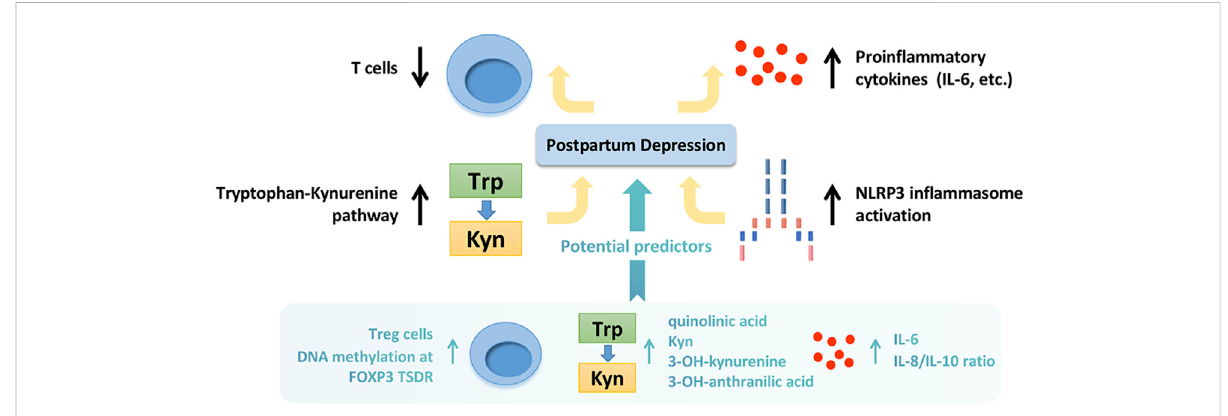
FIGURE 2 The in fl ammatory mechanisms implicated in postpartum depression and potential predicted markers. The in fl ammatory mechanisms implicated in postpartum depression include decreased T cell activation, up-regulation of proin fl ammatory cytokines, activation of kynurenine pathway, and activation of NLRP3 in fl ammasome. The potential predicted in fl ammatory markers include increased Treg cells prenatally, upregulation of IL-6 and Hs-CRP at delivery, high DNA methylation at FOXP3 TSDR prenatally, increased IL-8/IL-10 ratio during the third trimester, and high level of quinolinic acid, Kyn, 3-OH-kynurenine and 3-OH-anthranilic acid during pregnancy. Trp, tryptophan; Kyn, kynurenine; Treg cells, regulatory T cells; IL, interleukin; Hs-CRP, high-sensitivity C-reactive protein; DNA, deoxyribonucleic acid; TSDR, Treg-cell-speci fi c demethylated